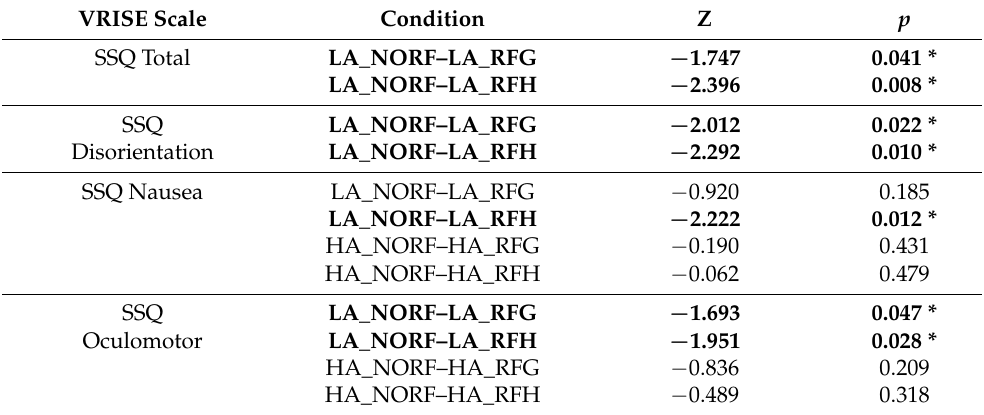
Table 3. Wilcoxon signed-rank test for the SSQ scores between the no rest-frame and rest- frames conditions. VRISE